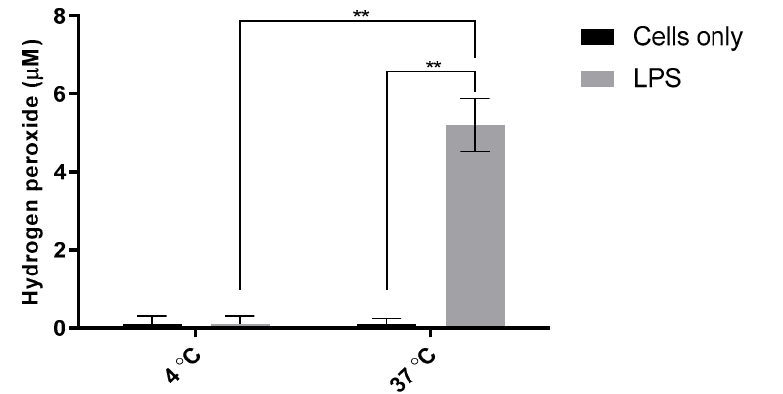
Figure 9. Effect of reduced incubation temperature on H 2 O 2 production in RAW 264.7 cells. LPS- doped cells received 200 ng/mL in each well. Cells were incubated for 48 h at 4 °C or 37 °C (5% CO2) following addition of LPS. Probe sensitivity: 11.0 pA/µM; R 2 , 0.9997. One-way ANOVA ( n = 8, p <